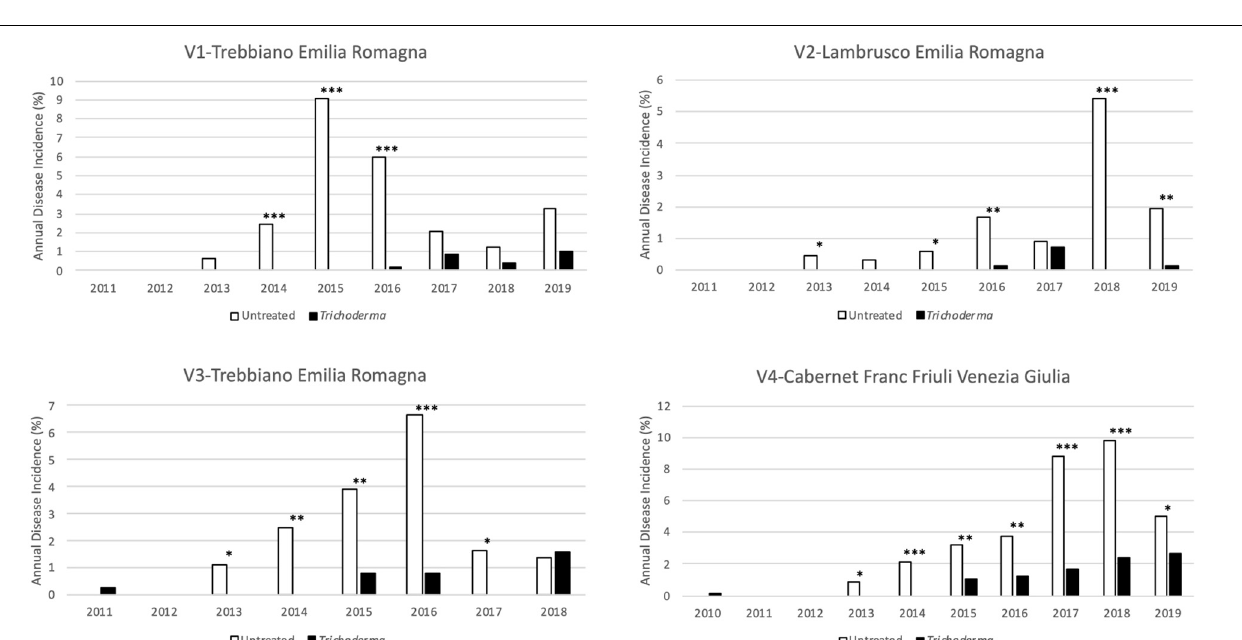
identical in V2 and V4 vineyards and very close in V1 and